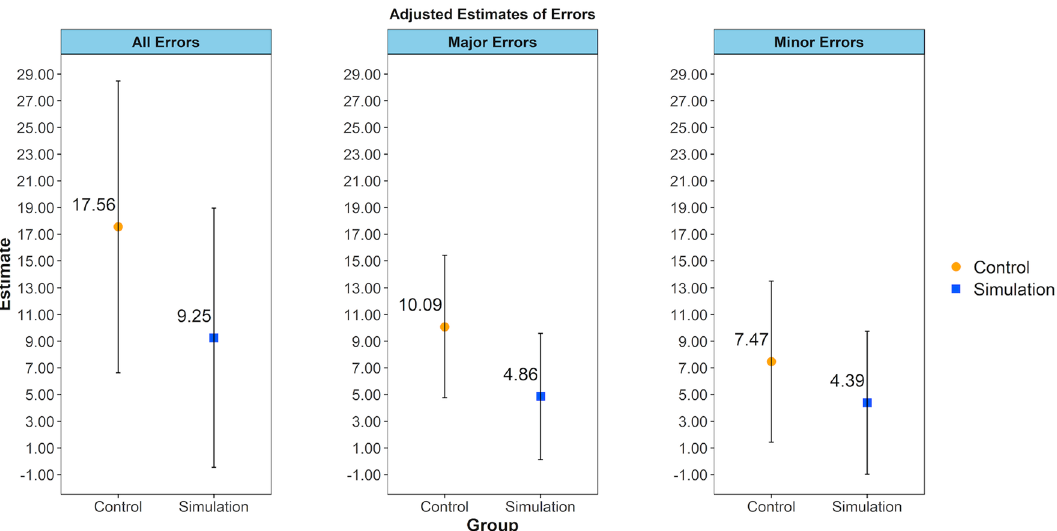
Figure 5. Adjusted estimates for average counts of errors over the initial 20 procedures performed by trainees in